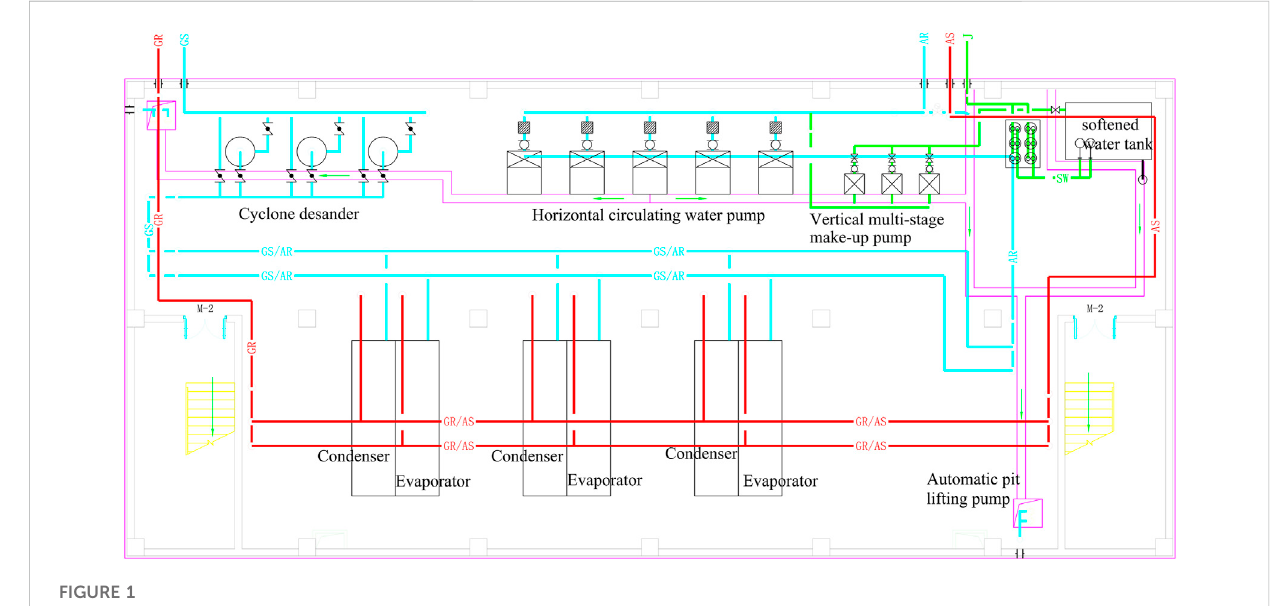
FIGURE 1 System fl ow chart of the equipment room.